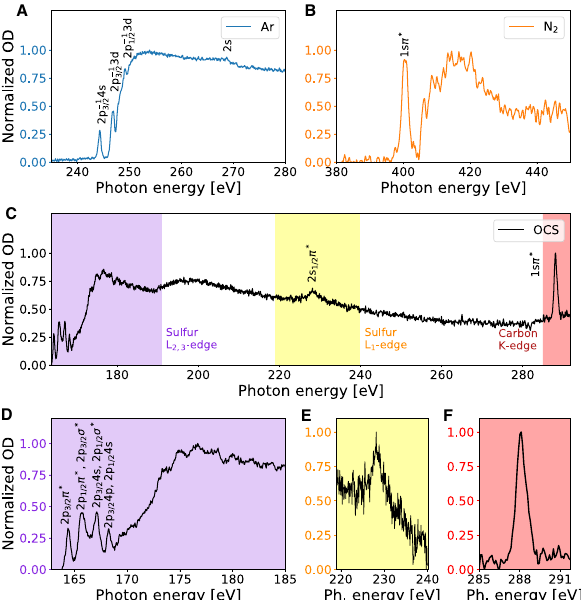
Figure 5. Static X-ray-absorption spectra of ( A ) argon at the L 1,2,3 -edges, ( B ) diatomic nitrogen at the K-edge, and ( C ) carbonyl sulfide at the sulfur L-, and carbon K-edges simultaneously. Zoom of the carbonyl sulfide absorption spectrum at the sulfur L 2,3 -edges ( D ), sulfur L 1 -edge ( E ), carbon K-edge ( F ). The reported OD values have been normalized between zero and one per each region of